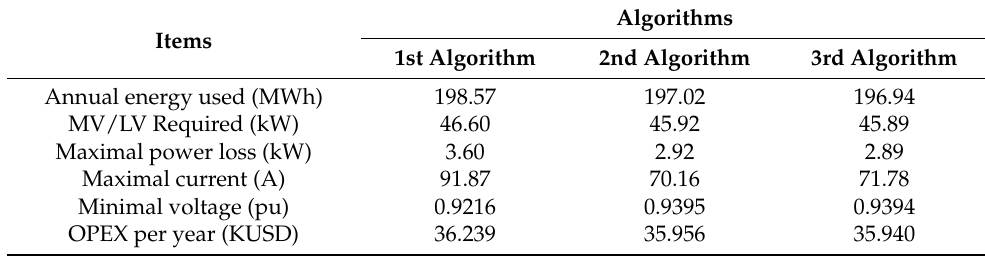
Table 4. Performance indicators of different algorithms for the low voltage distribution